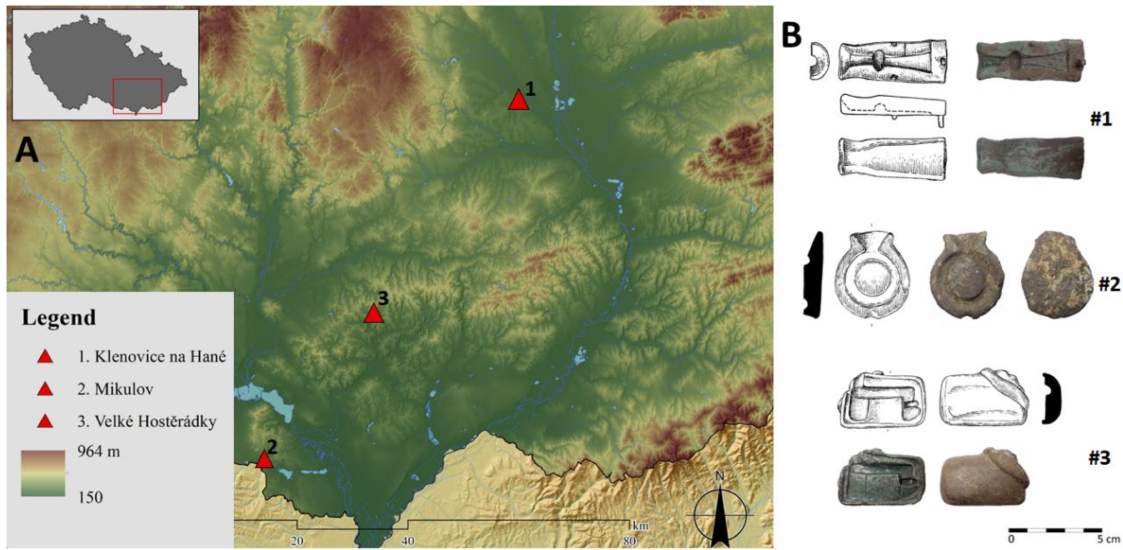
Figure 1. Map of the Moravian region with the locations of finds ( A ), photos and drawings of studied molds ( B